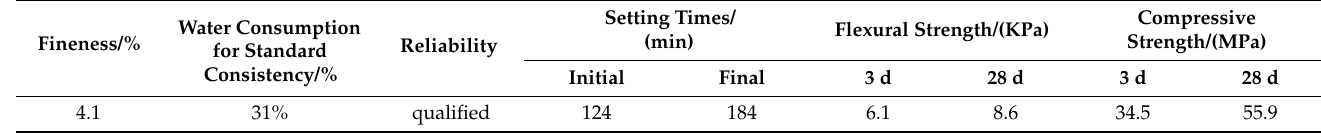
Table 3. Fundamental properties of the cement used.